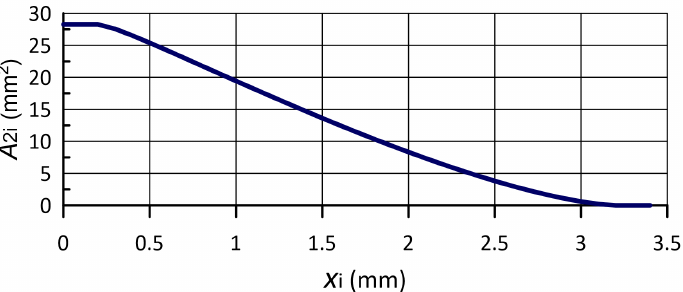
Figure 4. Output nozzle area of the flow control valve against the spool